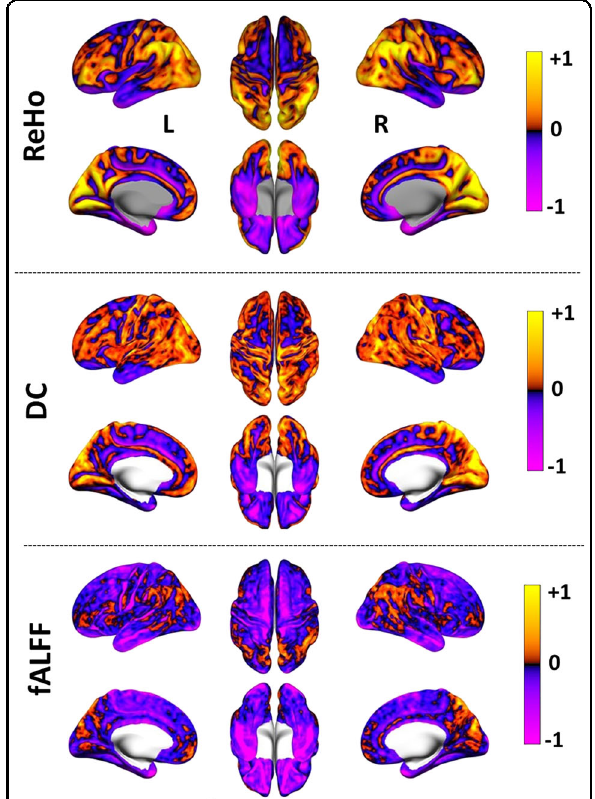
Fig. 3 RS-fMRI measures. Z -value standardised measures 3D images representing regional homogeneity (ReHo — top row), degree centrality (DC — middle row) and fractional amplitude of low- frequency fl uctuations (fALFF — bottom row) RS-fMRI measures averaged across all subjects are shown. The positively coloured regions in the 3D images show higher short-range functional connectivity in ReHo, long-range functional connectivity in DC and BOLD signal fl uctuations in fALFF. The left, superior and right views are shown in the upper rows and left medial, inferior and right medial views are shown in the lower rows of each RS-fMRI